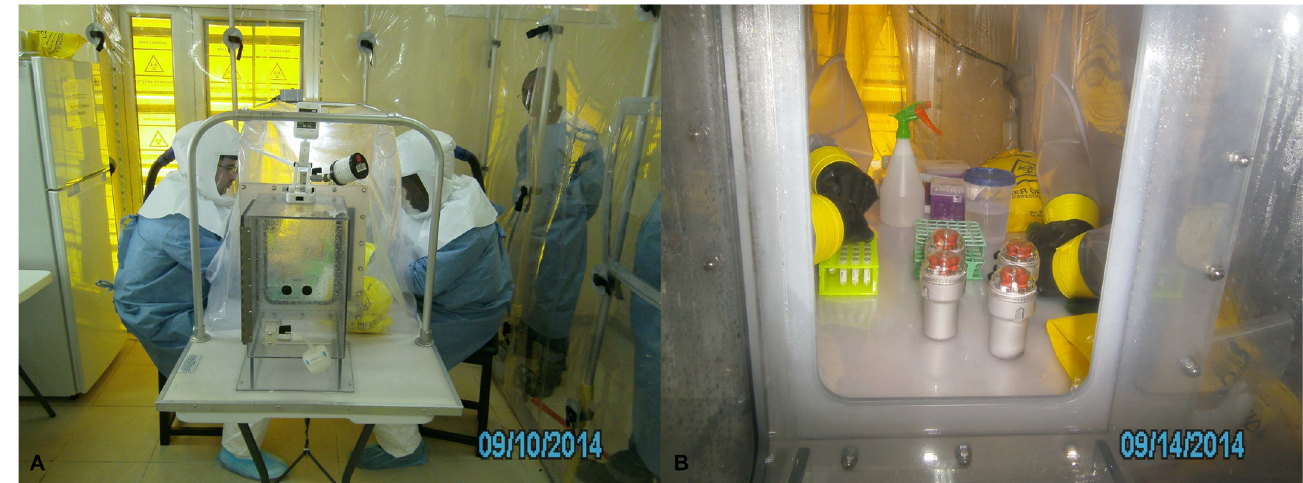
Fig 3. ( A ) Operators dressedin BSL3 PPE processingclinicalspecimensfrom EVD suspected cases in a gloveboxlocated within the IsoArk biocontainment negativepressure chamber, ( B ) Blood tubes in centrifuge adapters with safety caps passed into the main chamberof the glovebox for “hot” inactivation and aliquotingfor long-term